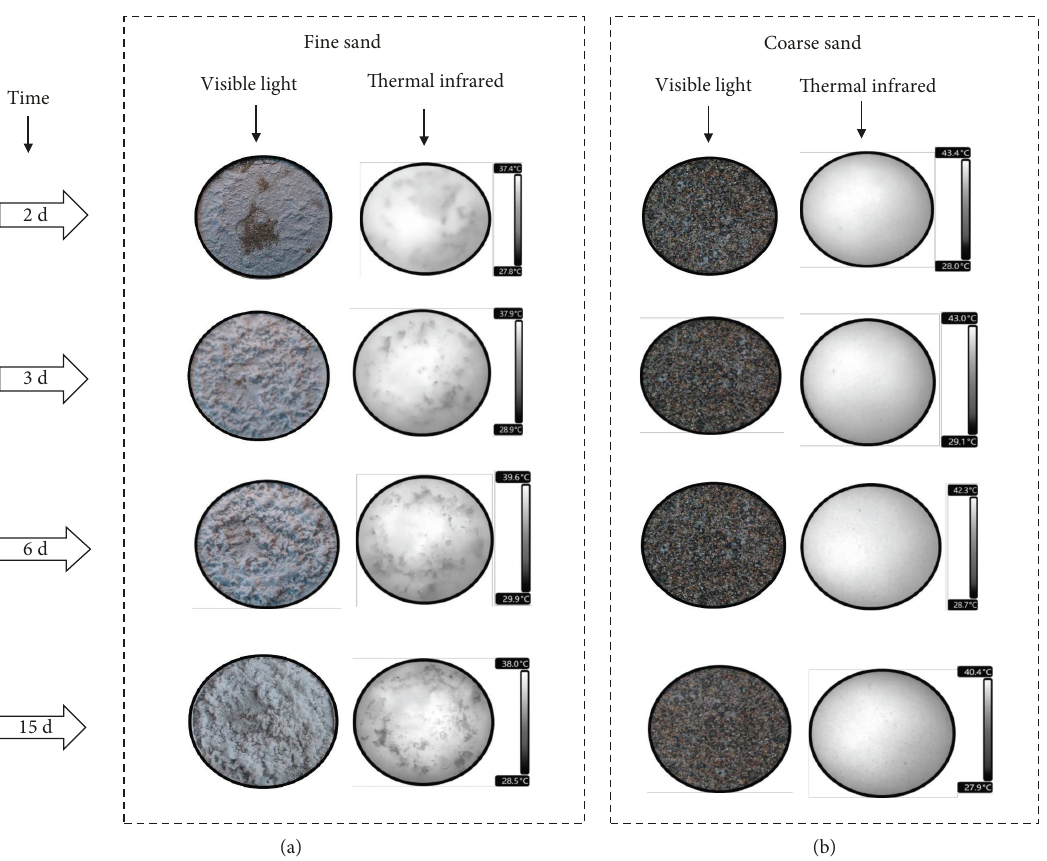
Figure 2: Dynamic variation in salt precipitation (visible light images) and thermal infrared images for homogeneous sand columns: (a) fine sand; (b) coarse